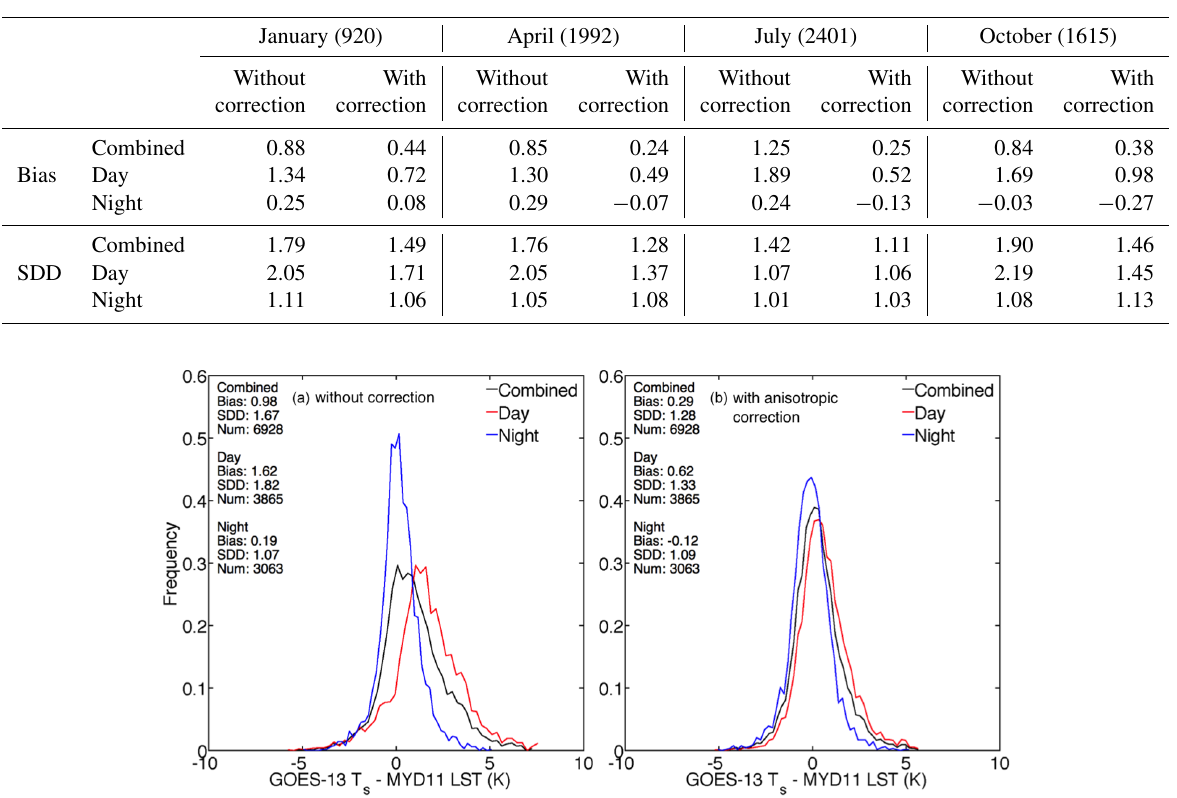
Table 3. Bias and SDD values (K) for the GOES-13 and the MYD11 Aqua MODIS product comparison for day, night, and all times combined separated by 2013 seasonal month, without and with the Vinnikov et al. (2012) three-kernel anisotropic correction applied. The numbers in parentheses indicate the sample size for that month.